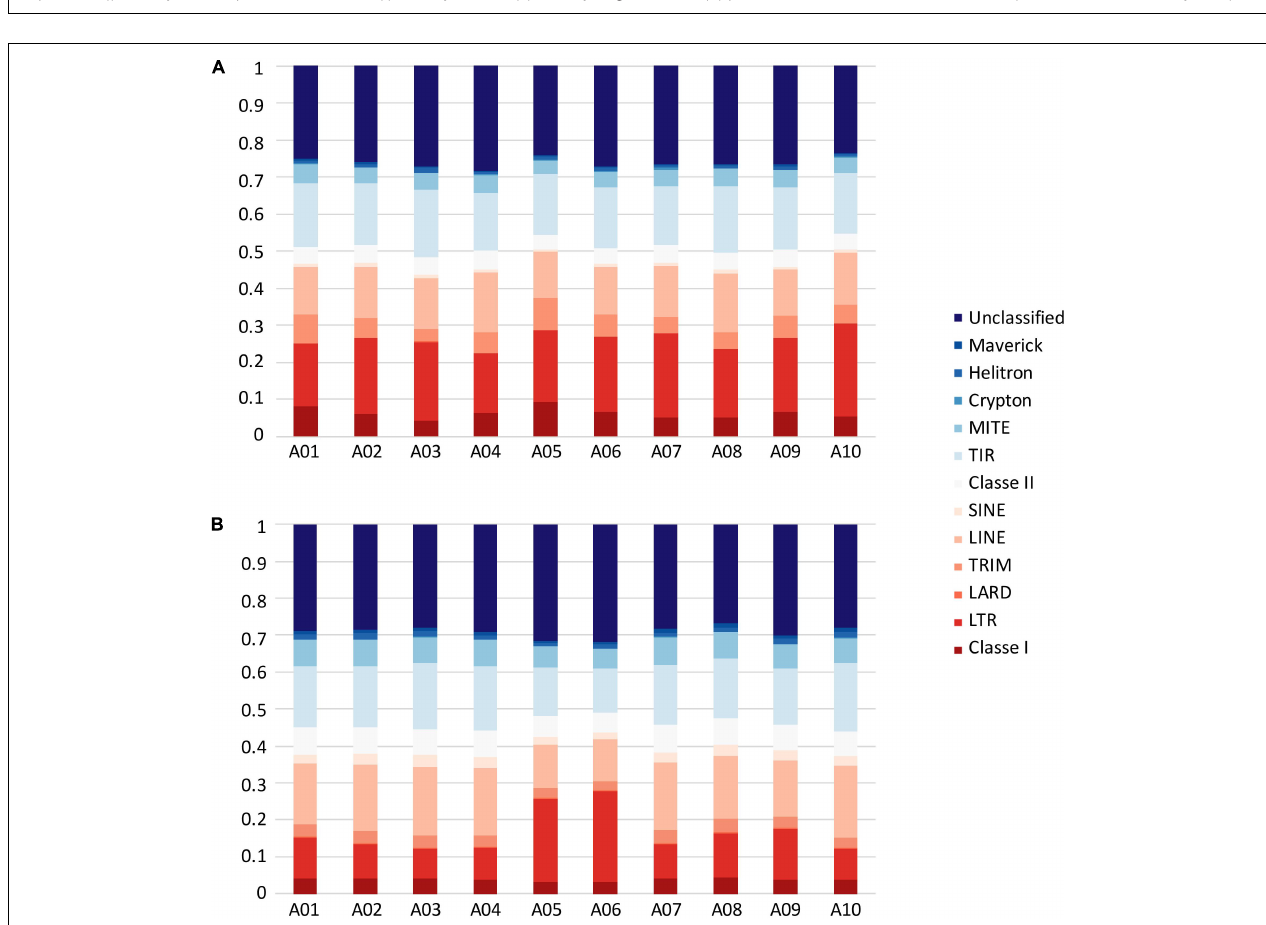
FIGURE 3 | Transposable element proportions in the 10 chromosomes of (A) B. rapa ‘Chiifu’ and (B) B. rapa ‘Z1.’ Class I and Class II corresponded to unclassified TEs within their respective Class.